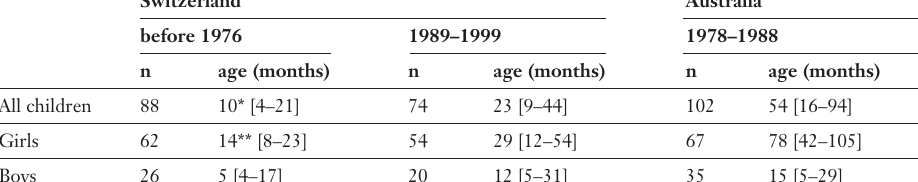
Age at diagnosis of 162 Swiss (46 boys and 116 girls) and 102 Australian (35 boys and 67 girls, diagnosis before 1976; from reference 3) children with vesicoureteric reflux detected after urinary tract infections. Results are given as number of patients and median and interquartile range of the